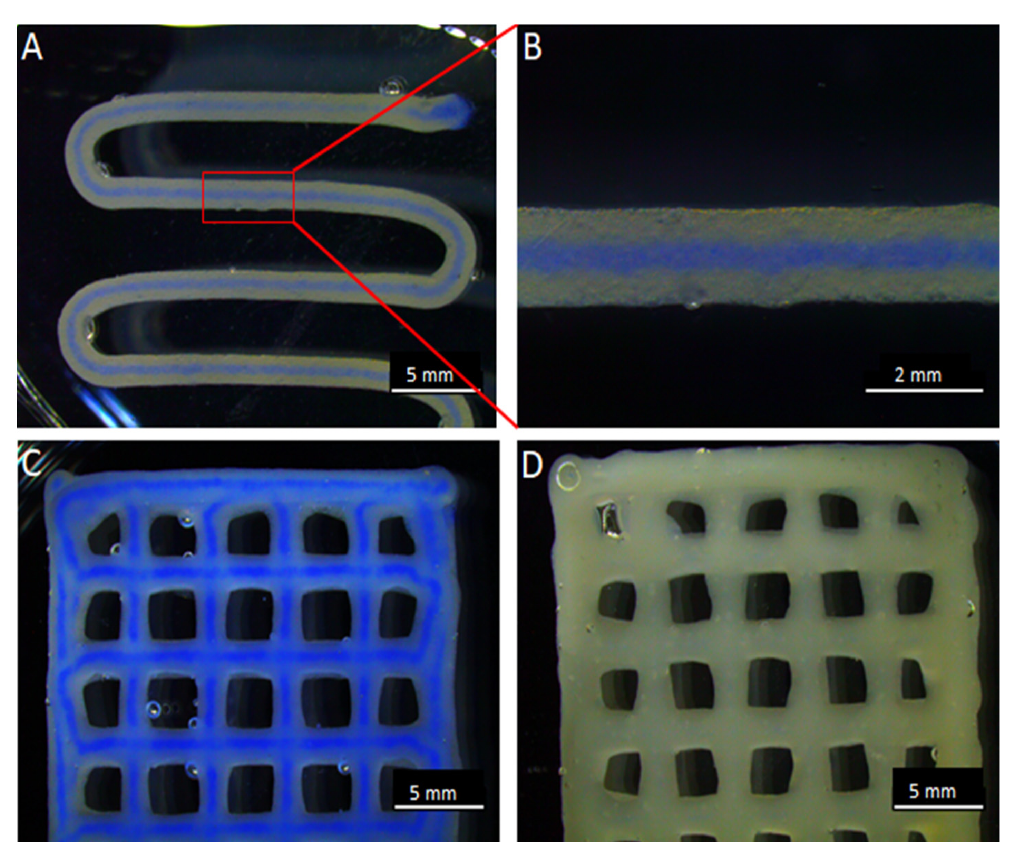
Figure 3. 3D Core/shell printing. A C/S scaffold with the shell composed of ALG-MC-LAP and the core of 3% alginate, coloured with blue ink for visibility, after 1 layer of 3D printing ( A ). A magnified image of the C/S strand ( B ). C/S scaffold of 4 layers after finishing the 3D printing ( C ). A full strand (i.e., no core) 3D bioprinted scaffold of 4 layers ( D ).